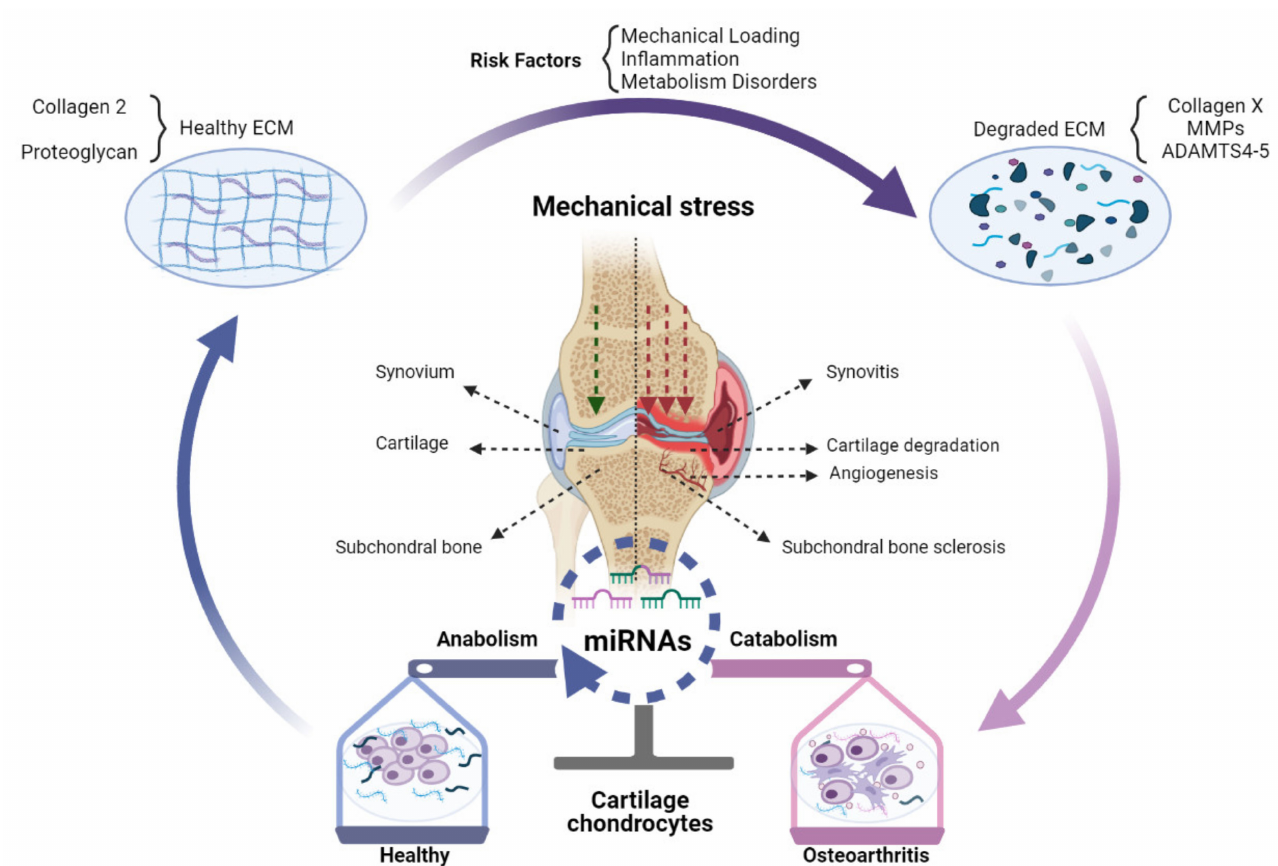
Figure 1. The role of miRNAs in OA pathogenesis. Changed expression of miRNAs in OA chondrocytes can shift the balance of homeostasis, which can impose a protective effect (blue), destructive effect (pink), or both (merged blue and pink) on chondrocytes. A healthy knee joint could synthesize and secrete normal ECM mainly comprised of Collagen 2 and proteoglycan. Risk factors of OA, especially abnormal mechanical stress, inflammation, and metabolic disorders, can destroy ECM and induce excess expression of Collagen X, MMPs, and ADAMTS-4,5, accelerating cartilage destruction. These processes can be epigenetically modulated by miRNAs expressed in cells of the joint tissues, chondrocytes, synoviocytes, and subchondral bone cells. As a result, chondrocyte metabolism can be changed from anabolic towards catabolic, which in turn accelerates the degradation of cartilage together with subchondral bone sclerosis, angiogenesis, and